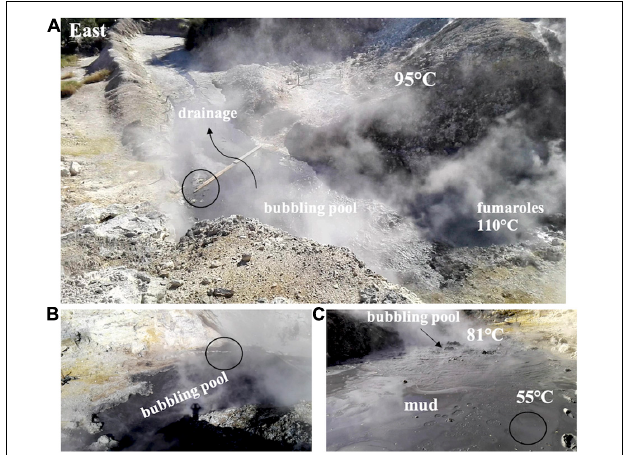
FIGURE 1 | The Pisciarelli site, the sample mud pool, and the sample area (white circle). (A) The hydrothermal setting with the fumaroles, the main boiling pool, the outflow water drainage zone, and the surrounding diffuse degassing area. (B) Southern view of the bubbling pool with the boiling points. (C) The sampled muddy area at the periphery of the mud